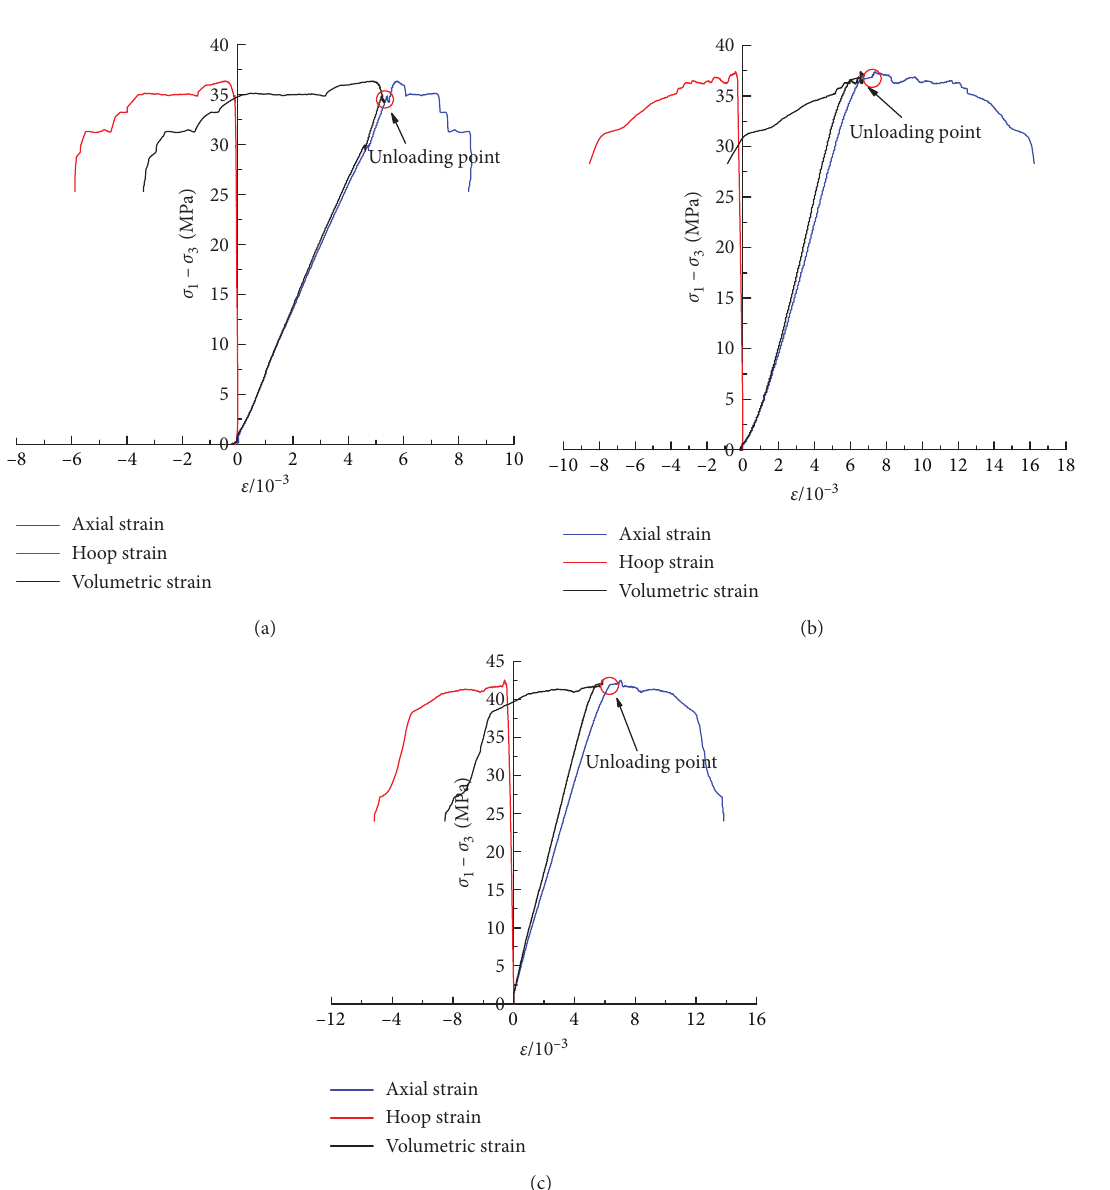
Figure 4: Stress-strain curves under different initial confining pressures. (a) 4.0 MPa, (b) 6.0MPa, and (c)